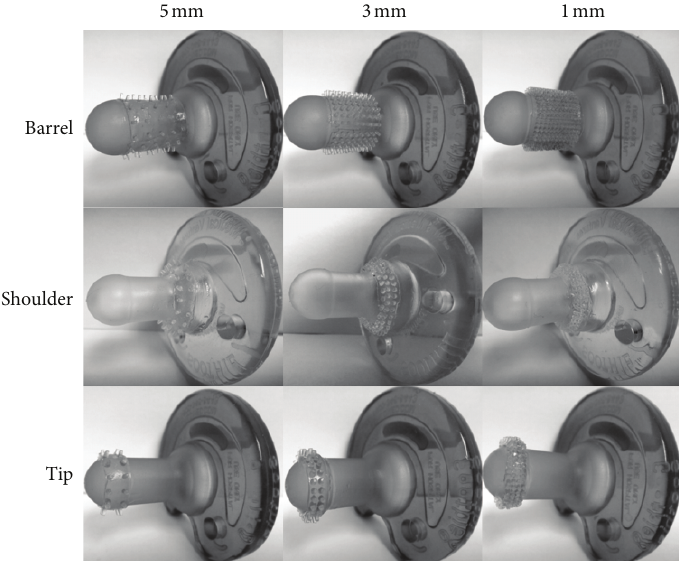
Figure 1: Examples of textured pacifiers. Spatial array density is represented by columns, spatial array location by